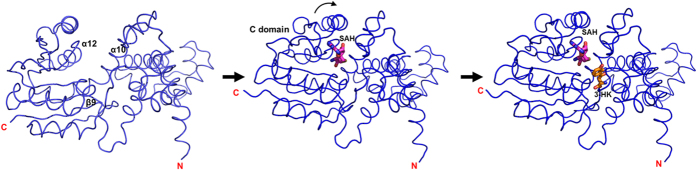
The conformational change of Ss-SibL. Structures of Ss-SibL reveal that conformational change of the C-terminal domain triggered by SAH binding, followed by 3-HK binding that does not cause any major structural change.